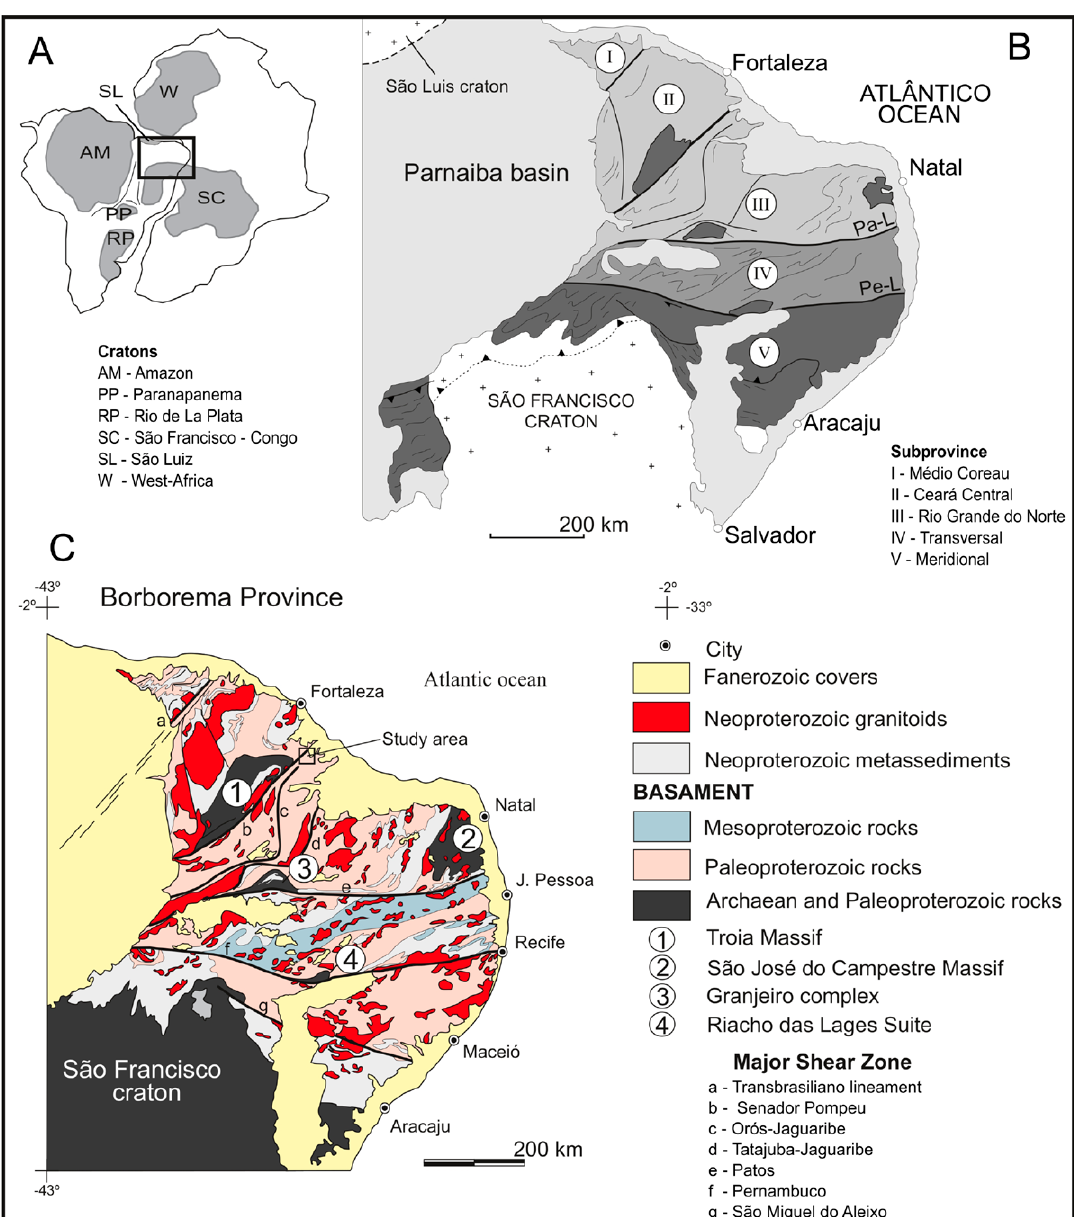
FIGURE 1 – (A) Paleogeographic configuration of the Gondwana Supercontinent at ca. 600 Ma. (B) Tectonic subprovinces of the